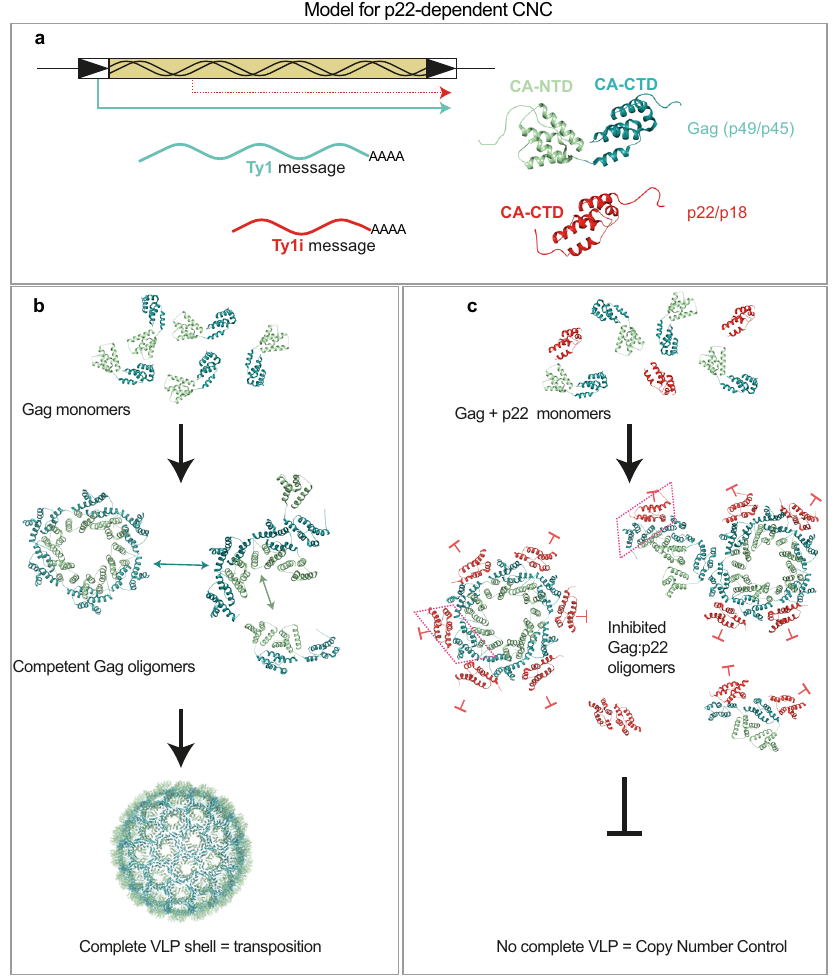
Fig. 7 Model for p22/p18-dependent CNC. a Transcription of Ty1 results in either a full-length Ty1 transcript (teal), or a short, inhibitory transcript Ty1i (red). The long transcript encodes full-length Ty1 Gag and Pol proteins, shown in green/cyan cartoon. The shorter Ty1i transcript encodes p22/p18, a C-terminal portion of Gag equivalent to a CA-protein CTD, lacking an NTD (red cartoon), as well as Pol proteins, which are not required for restriction 25 . b Full-length Gag monomers assemble into oligomers through NTD-NTD, and CTD-CTD interactions to construct an icosahedral shell, constituting the VLP, which is required for transposition. c In the presence of p22/p18, Gag monomers are also able to oligomerise with p22/p18 through CTD-CTD interactions. Two examples of a Gag- p22/p18 hetero-interaction through the CTD interface are highlighted by the trapezoidal boxes. While Gag proteins may be able to homo-oligomerise through their NTDs, Gag oligomers that associate with p22/p18 become assembly dead ends resulting in partially assembled particles that cannot